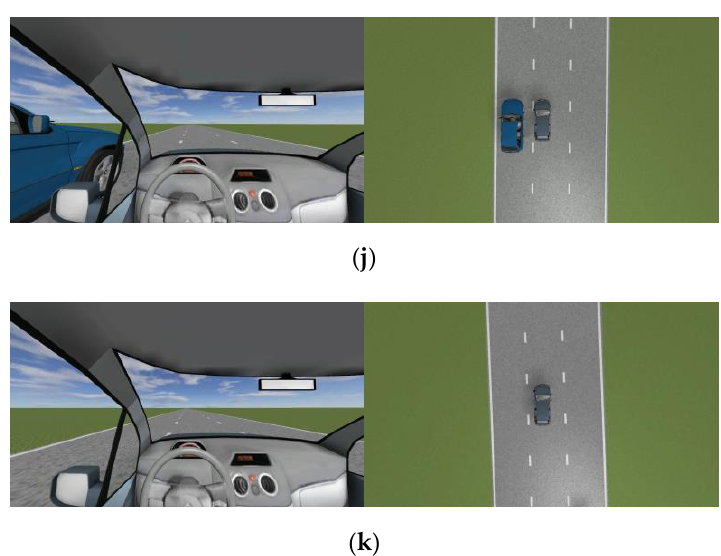
Figure 14. The positional relationship between the tested vehicle and the cluster environment during the test. ( a ) Vehicle starts (Phase I); ( b ) vehicles enter the cluster environment (Phase II); ( c ) vehicle is ready to overtake (Phase III); ( d ) vehicle lane change (Phase IV); ( e ) vehicle enters the car-following state (Phase IV); ( f ) vehicle overtakes the vehicle on the right side (Phase IV); ( g ) vehicle is ready to pass the right vehicle (Phase V); ( h ) after passing the vehicle, it moves into the right lane (Phase VI); ( i ) vehicle enters the car-follow state (Phase VII); ( j ) the vehicle passes the left vehicle and exits the cluster environment (Phase VII); ( k ) the vehicle enters a free-driving state (Phase VII).